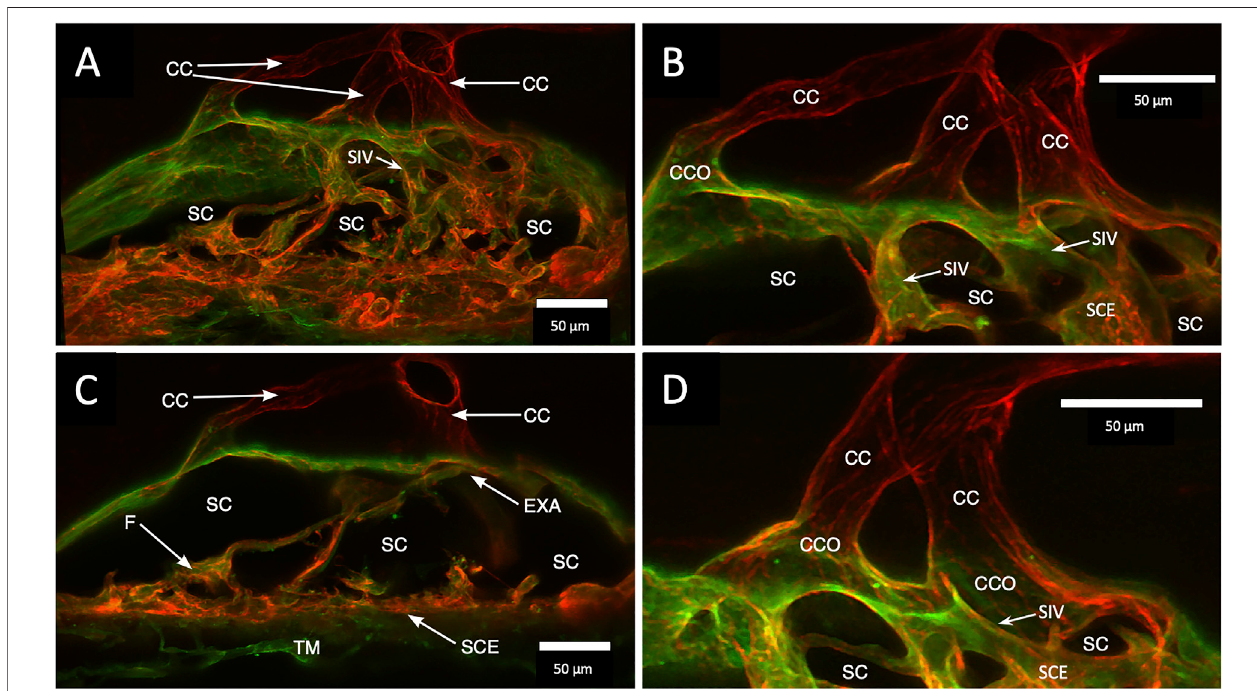
FIGURE4| Clari fi cation revealsSchlemm ’ scanal structure and collectorchannel relationships. (A) 112-µmthickconfocal stack3Dprojection ofmerged channels ofCD31(red)andColtype1(green).Clari fi cationpermitstheappreciationofcomplexconnectionsofthetrabecularmeshwork(TM)andSchlemm ’ scanal(SC)innerwall endothelium(SCE).SCinner wall valve-likestructures (SIV) arisefrom SCE.The SIV attach tothe SCexternal wallarea (EXA)at collectorchannel ostia (CCO) that leadto collectorchannels(CC). (B,C) Subsetstackof (B) 48 µmand (C) 18 µm.CCOsattheexternalwallleadtothreeCCtraversingthesclerathatjoinacircumferentially orientedintrascleralvessel. (A – D) SIVhavealumenapparentasvoidsincentralsectionsofserialconfocalimagestacks (D) stacksizeis42 µm.TheSIVwallsarelabeled with CD 31 and Col type 1-like SC inner wall and form a funnel (F) developing into acylinder attached to the SC external wall con fi rmed with serial confocal stack images